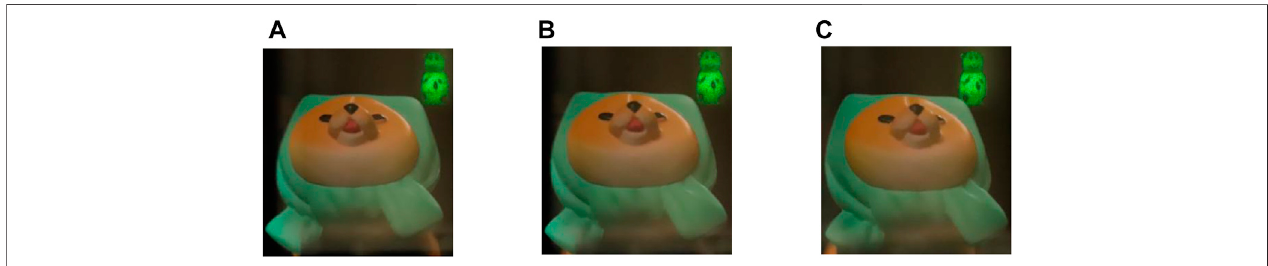
Frontiers in Materials |